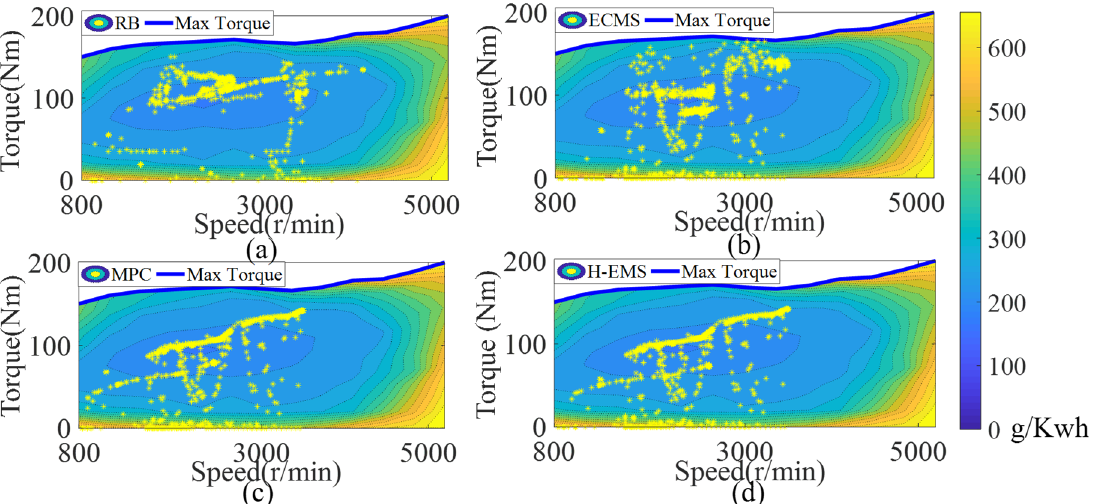
Figure 11. Engine operating points of energy management strategies. ( a ) RB strategy; ( b ) ECMS strategy; ( c ) MPC strategy; ( d ) H-EMS strategy.